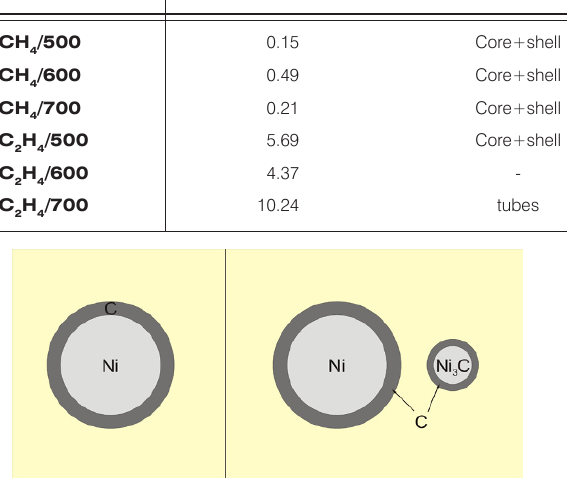
Figure 5. A schematic core-shell structure of the Ni/C nanoparticles obtained in carburization in methane (left-hand side), and ethylene (right-hand side). The dimensions of all shells is drawn to scale for the case of the carbon shell thickness on the Ni C core being two times smaller than on the Ni 3 core.